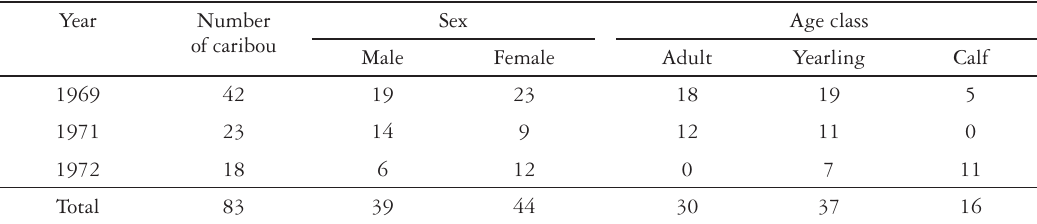
Table 1. Characteristics of the 83 caribou released in Charlevoix between 1969 and 1972, following breeding in